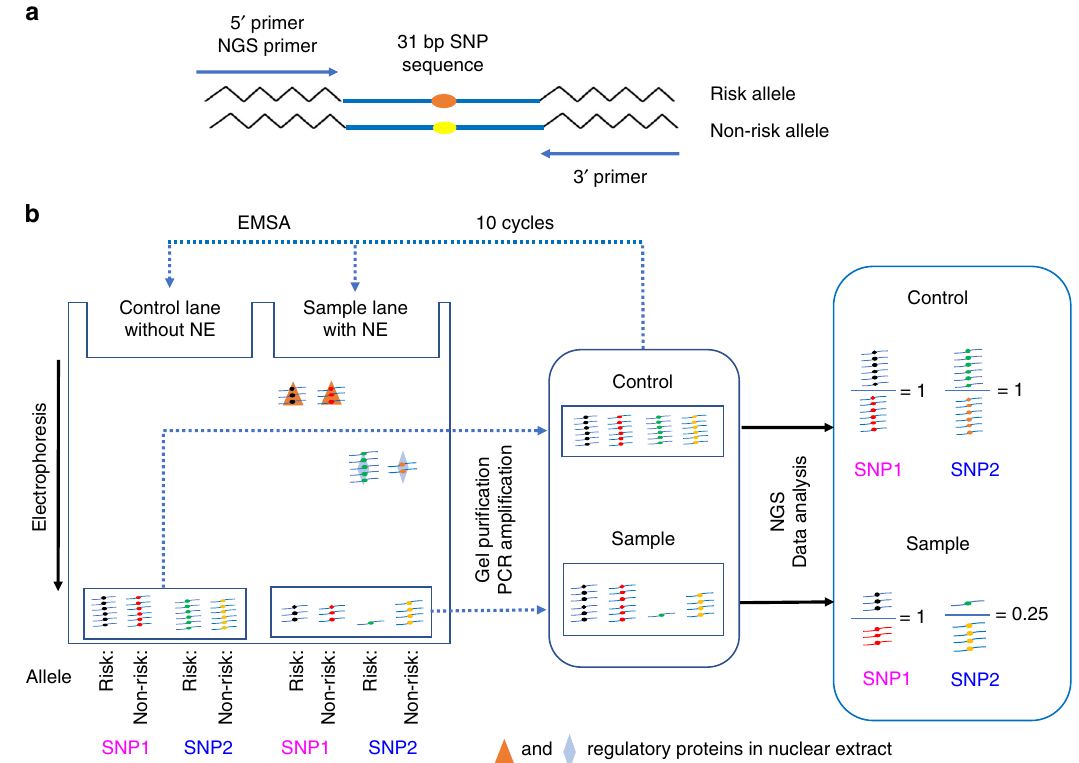
Fig. 1 Reel-seq for fSNP identi fi cation. a Reel-seq library construct. b Reel-seq to identify fSNPs. SNP1: a non-fSNP exhibiting a balanced gel shift pattern between risk and non-risk allele (left in purple); therefore, showing no difference in the ratio of risk and non-risk allele (right in purple) between the buffer- treated control and the NE-treated sample. SNP2: fSNP demonstrating allele-imbalanced gel shift pattern between the risk and non-risk allele (left in blue); therefore, showing signi fi cant difference between the buffer-treated control and the NE-treated sample (right in blue). Nonspeci fi c shifting is not shown on EMSA, but it is considered to be evenly and randomly distributed. EMSA electrophoresis mobility shift assay, NE nuclear extract, NGS next-generation